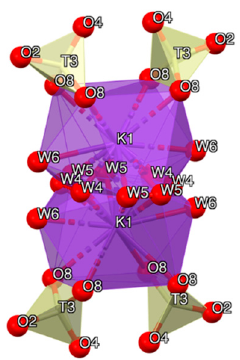
Figure 4. Details of the coordination of the extra-framework site K1.